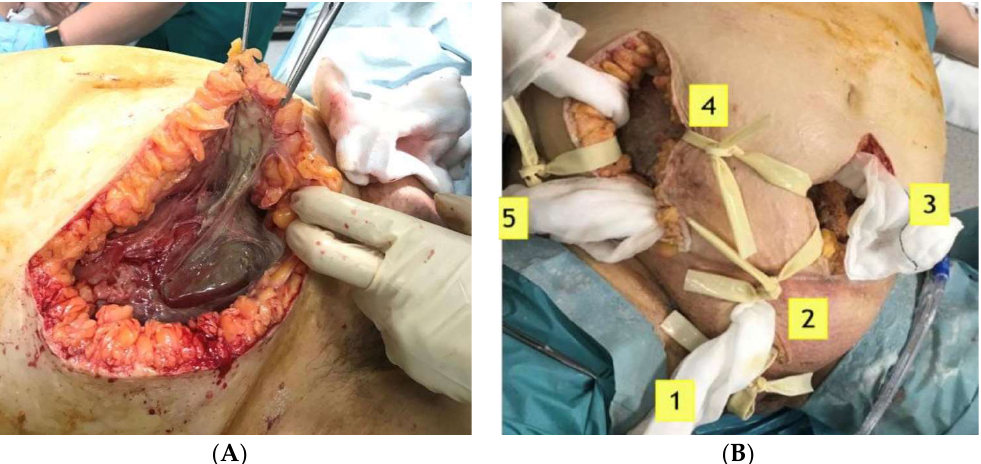
Figure 2. ( A ): Surgical treatment by aggressive debridement, pointing out the necrotic tissue below. ( B ): Reinterventions for removal of dead tissue, vacuum-assisted closure therapies, healthy tissue grafts are common in FG.